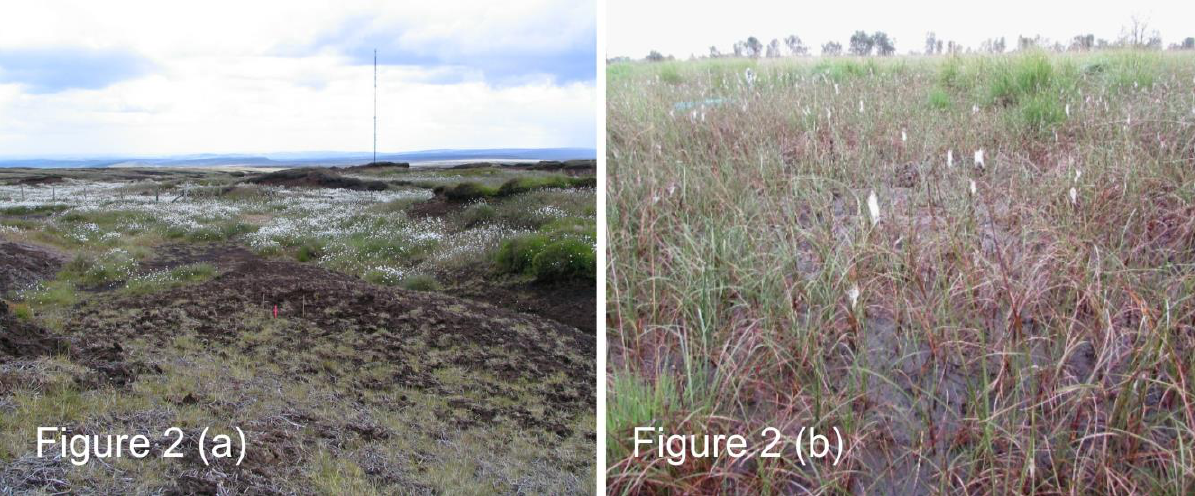
Figure 2. Landscapes typical of the upland and lowland degraded peatlands: (a) upland blanket bog landscape near Holme Moss in 2008 showing bare peat, peat with a thin cover of grasses following treatment with lime, fertiliser and grass seed, native plants (in this case mainly E. vaginatum ) and deep gullies resulting from erosion; (b) lowland cut-over peatland at Cadishead in 2014 after re-wetting and spontaneous recovery of E. angustifolium